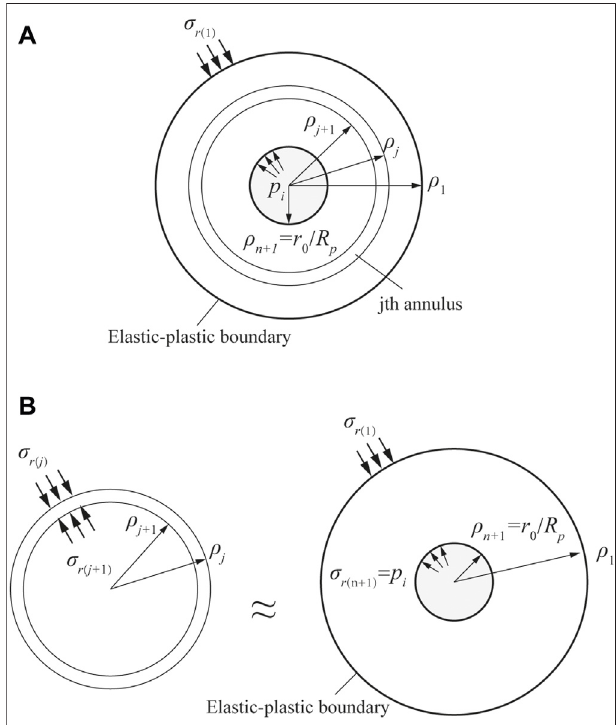
FIGURE 2 | Schematic fi gure of numerical calculation strategy: (A) plastic region divided into the fi nite number of annuli and (B) stress boundary of the j th